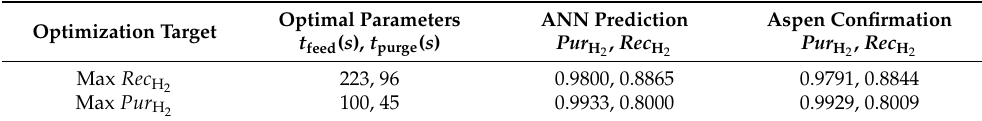
Table 5. Optimization results with ANN method and Aspen